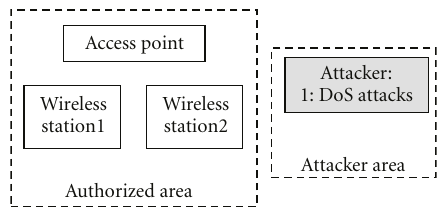
Figure 3: Simulation environment A for the IEEE 802.11 current model.